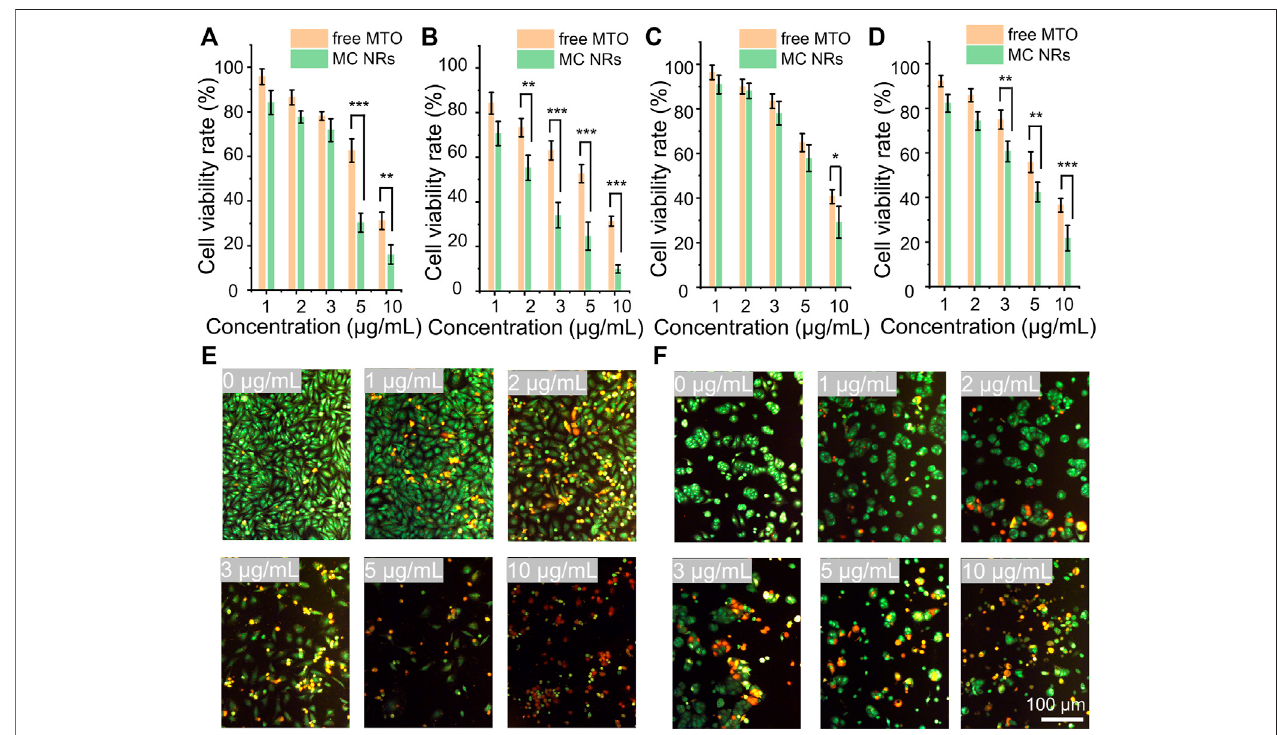
FIGURE6| Invitro antitumor performance.ThecellviabilityrateoftheHeLacellstreatedwithfreeMTOand MCNRsfor (A) 24 hand (B) 48 h. Thecellviabilityrate of the MCF-7 cells treated with free MTO and MC NRs for (C) 24 h and (D) 48 h. Fluorescence images showing (E) HeLa cells and (F) MCF-7 cells stained with AO (live cells,green fl uorescence)andEB(deadcells,red fl uorescence)afterculturingwithdifferentconcentrationofMTO-CaCO3NRs(intermsofMTO0,1,2,3,5,and10 μ g/ ml) for 24